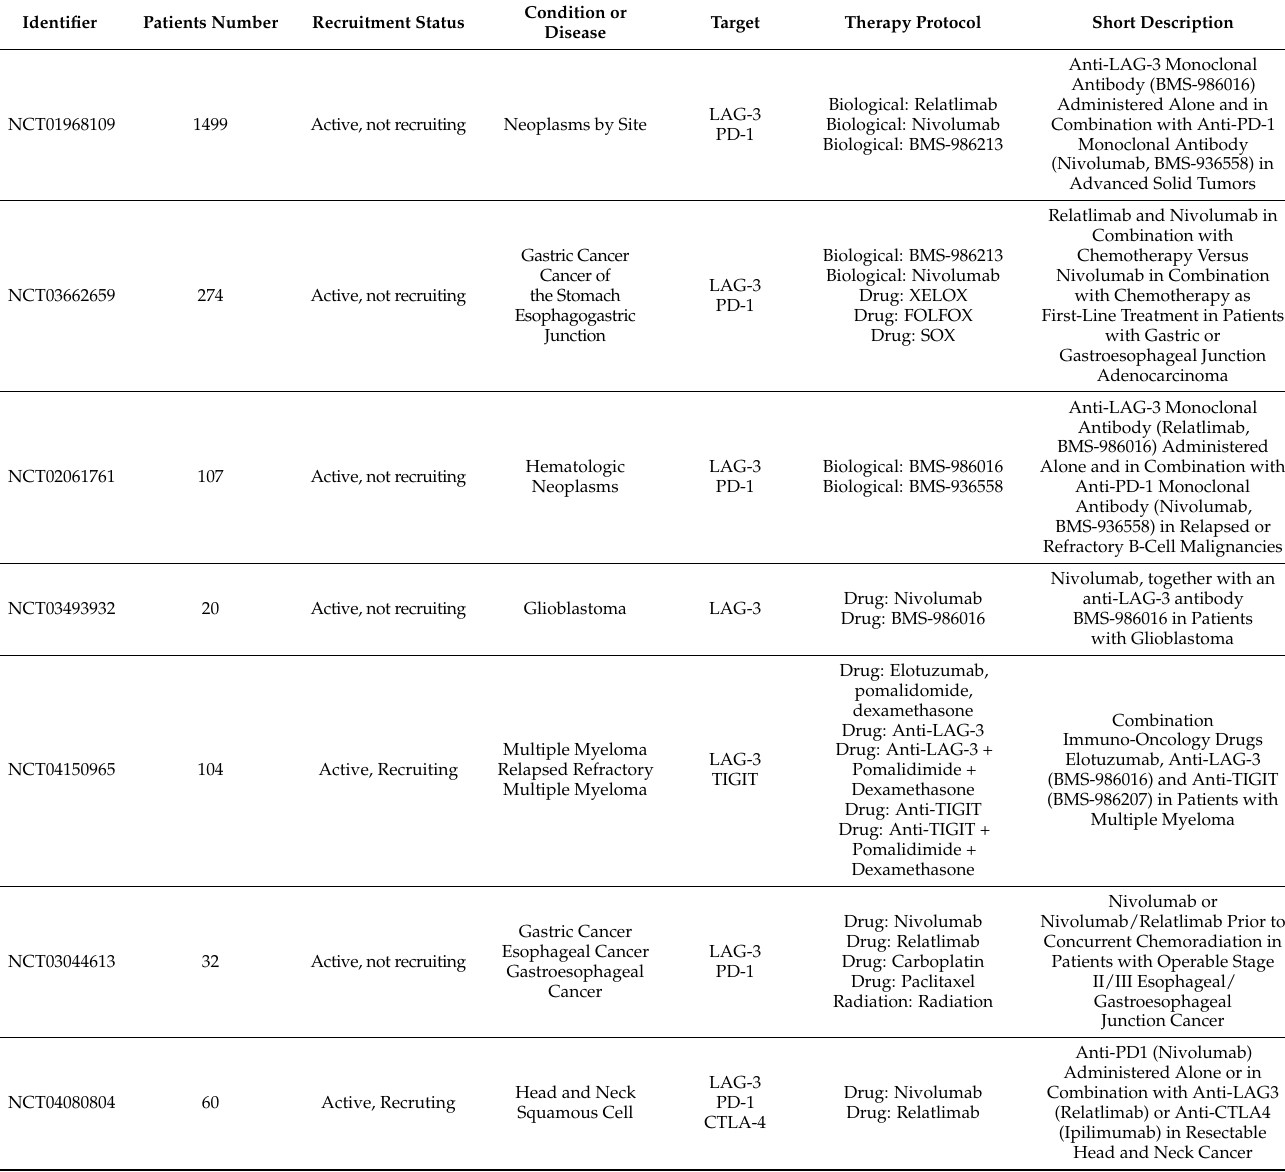
Table 1. Examples of Clinical Trials involving Anti-LAG-3 monoclonal